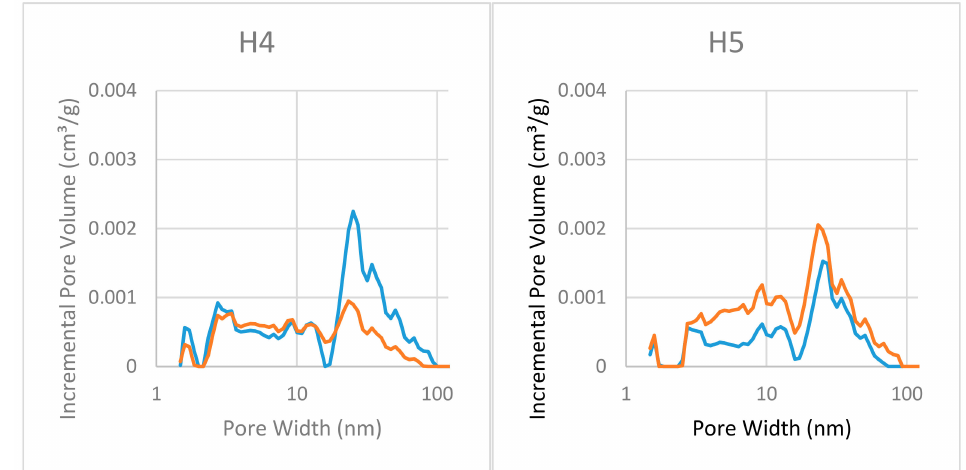
Figure 7. The pore size distribution of sample H4, representing the group of samples where the total pore area was reduced, and sample H5, representing the group of samples where the total pore area was enhanced.